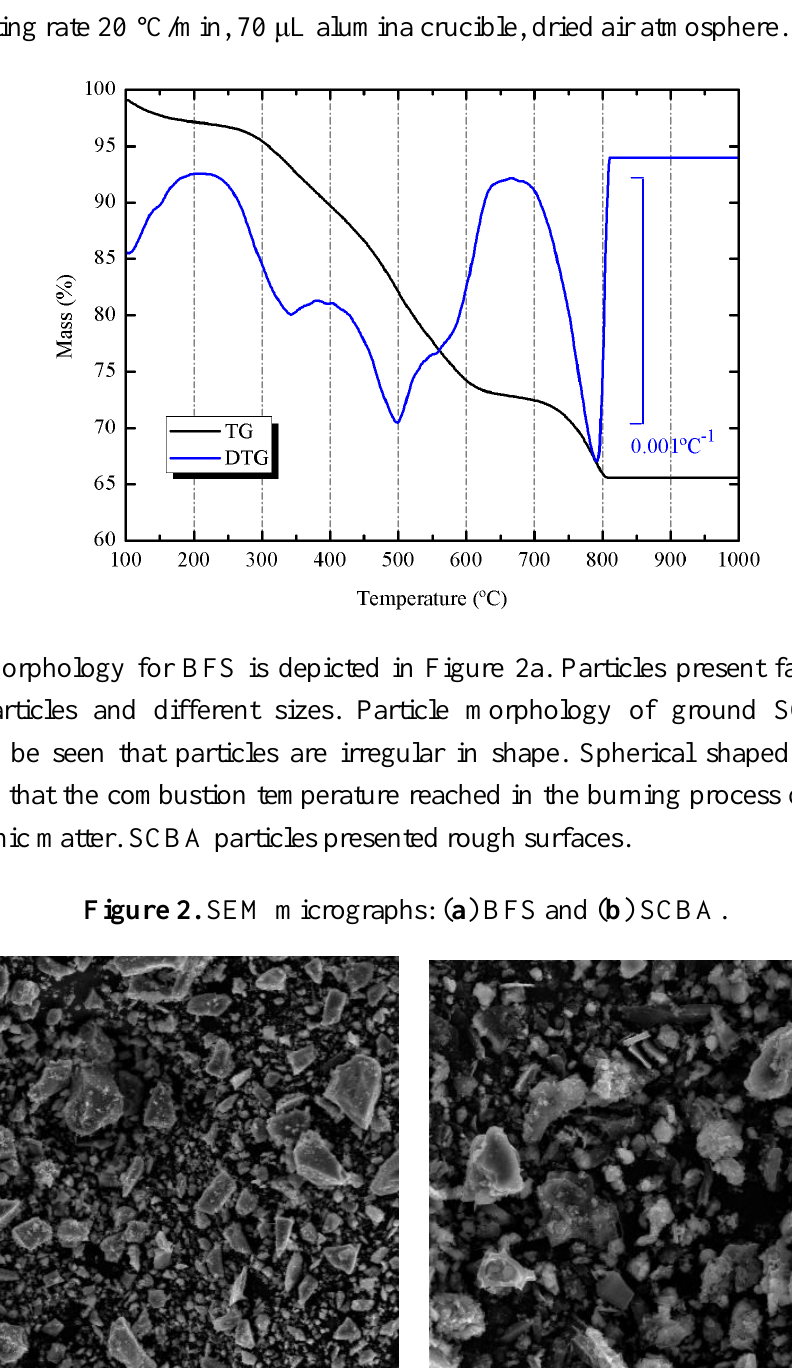
Figure 1. Thermogravimetric (TG) and derivative thermogravimetric (DTG) curves for